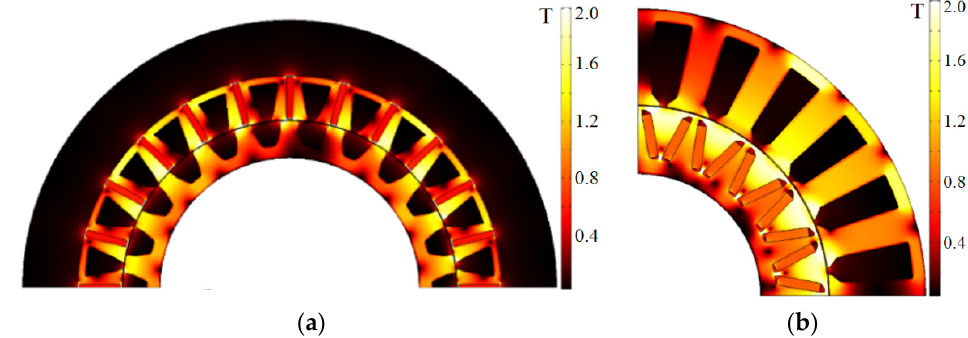
Figure 9. Optimized design and magnetic flux density at the rated mode: ( a ) PMFSG; ( b ) IPMSG. The losses in the PMFSG (blue asterisks) and the IPMSG (red asterisks) at nine modes of the profile presented in Table 1 are shown in Figure 10a. The losses in the PMFSG are higher than those in the IPMSG in a wide range of powers.